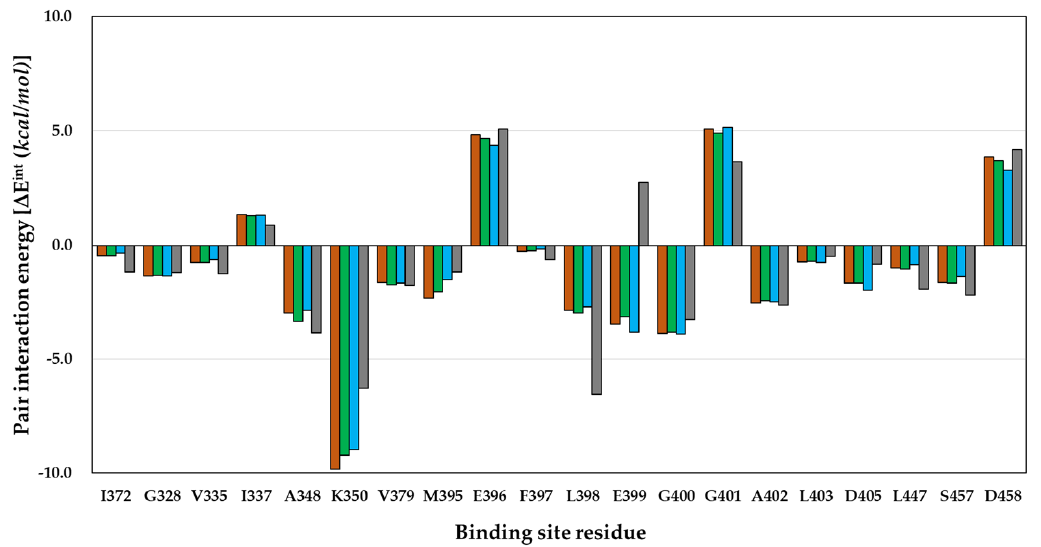
Figure 4. Comparison of calculated PIE in the FMO of compounds 1–4. Compounds 1, 2, 3, and 4 are shown in brown, green, light blue, and gray, respectively.